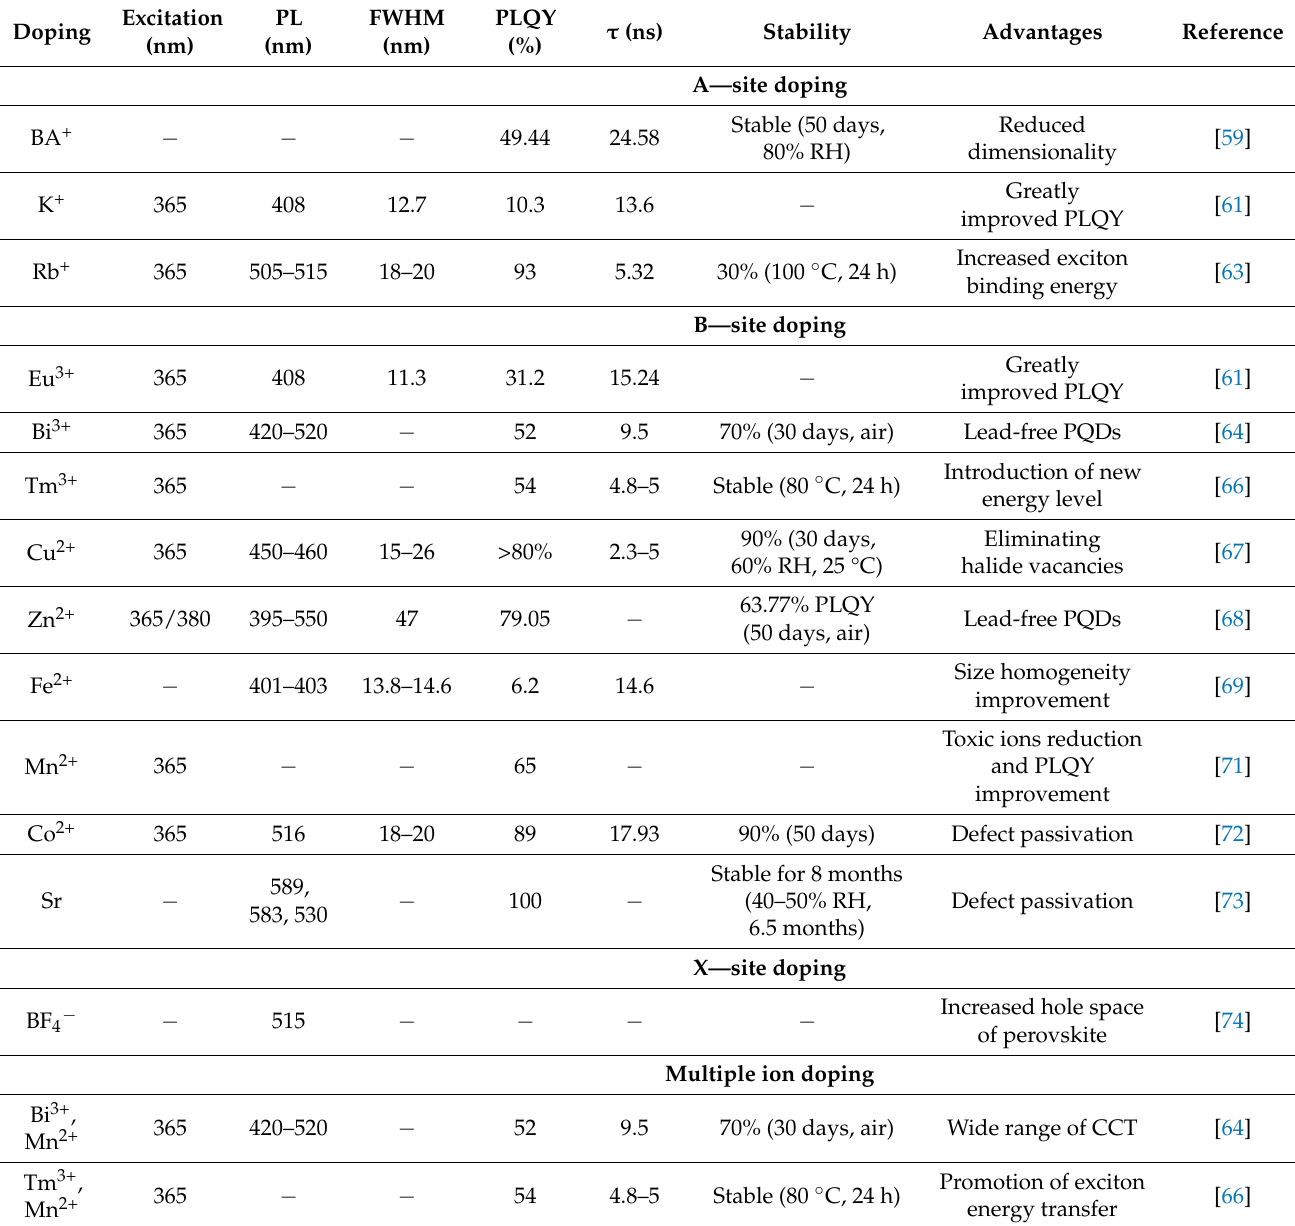
Table 2. Luminescence properties of different ion-doped